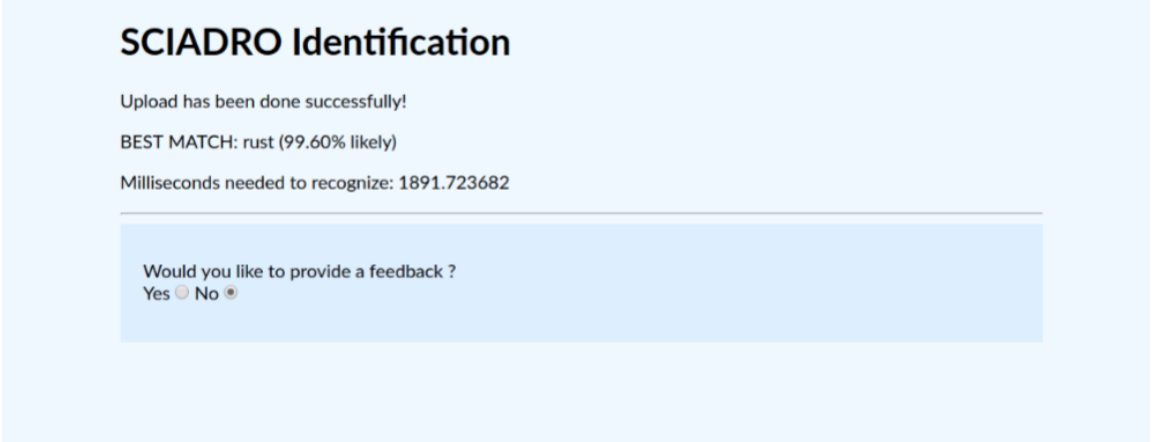
Figure 4. The web application layout resuming the processing output and performances.